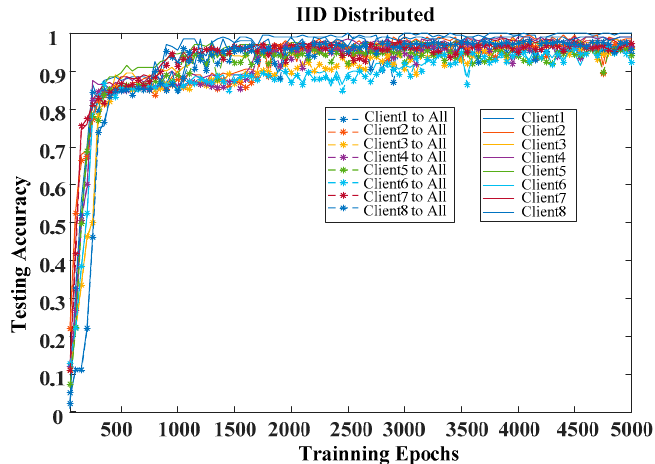
Figure 11. Accuracy rates trend under IID data distribution with network parameters isolated.